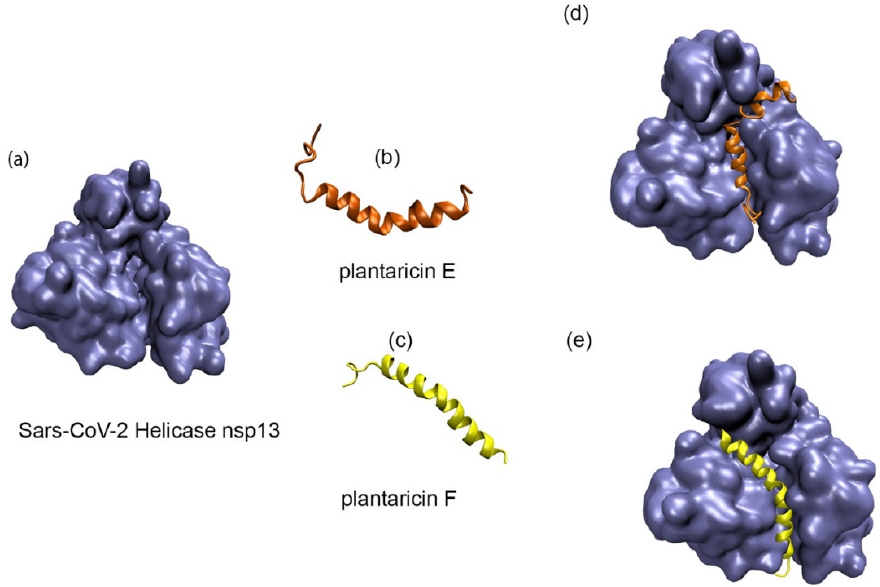
Figure 6. SARS-COV-2 Helicase nsp13 represented in secondary structure representation. The in- teracting residues for both ss-RNA and ATP binding are in red (Ser485, Lys146, Lys139, Tyr180, His230, Tyr198, Arg212, Pro335, Arg339, Asn516) and violet (Glu537, Arg567, Arg443, His290, Arg442, Asn265, Gly439, Lys288) respectively.